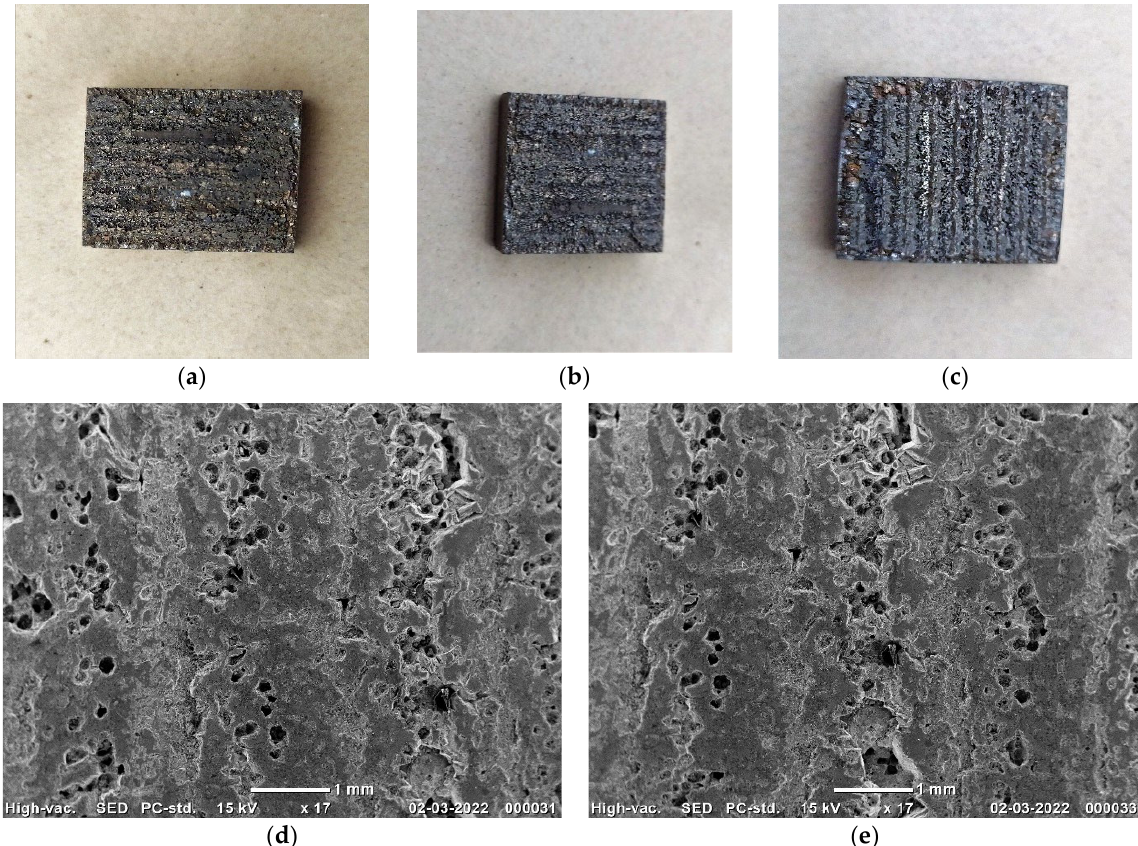
Figure 6. Wear tracks on ( a – c ) cladded specimens and ( d , e ) SEM images.